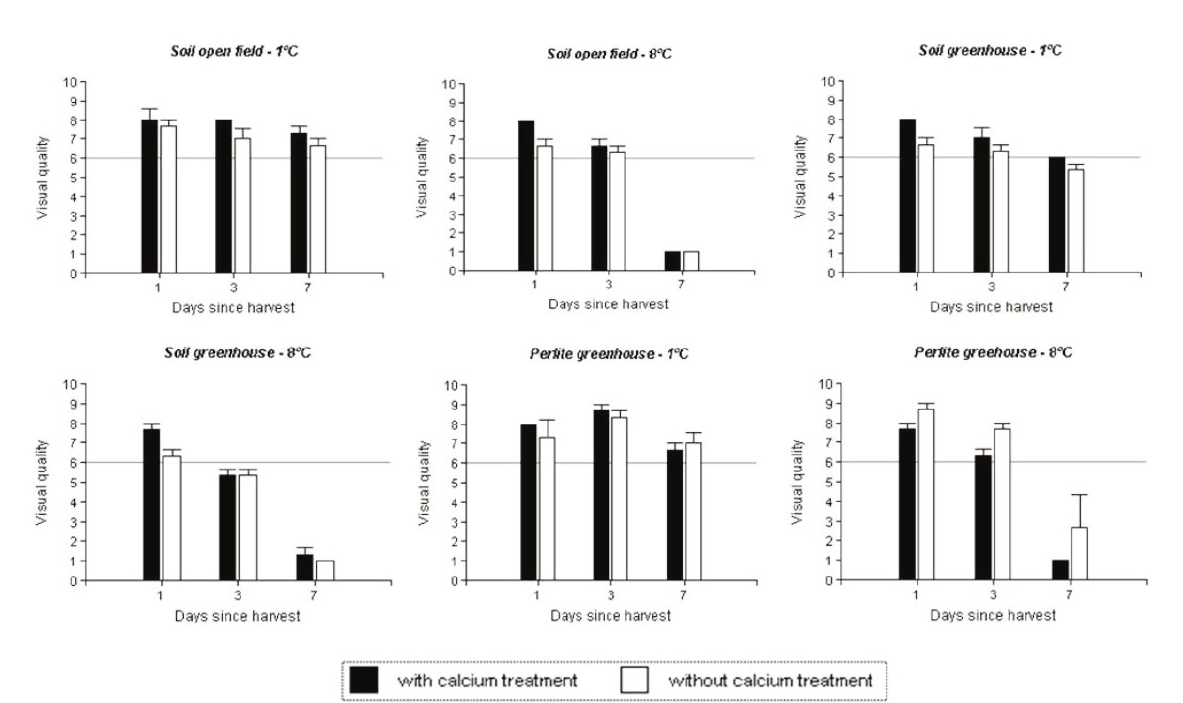
Fig. 3 - Visual quality at 1, 3 and 7 days of postharvest of strawberries grown in different growing systems, calcium lactate treatment and two storage temperatures. Each graph represents a combination of growing system and storage temperature. Commercialization limit (6) is